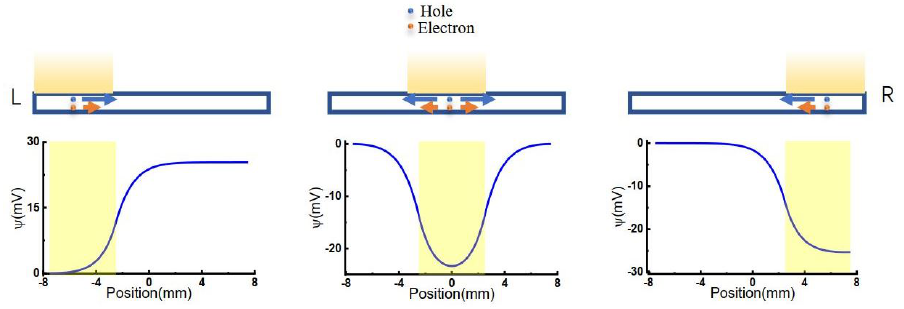
Figure 1. Scheme of carriers’ diffusion and